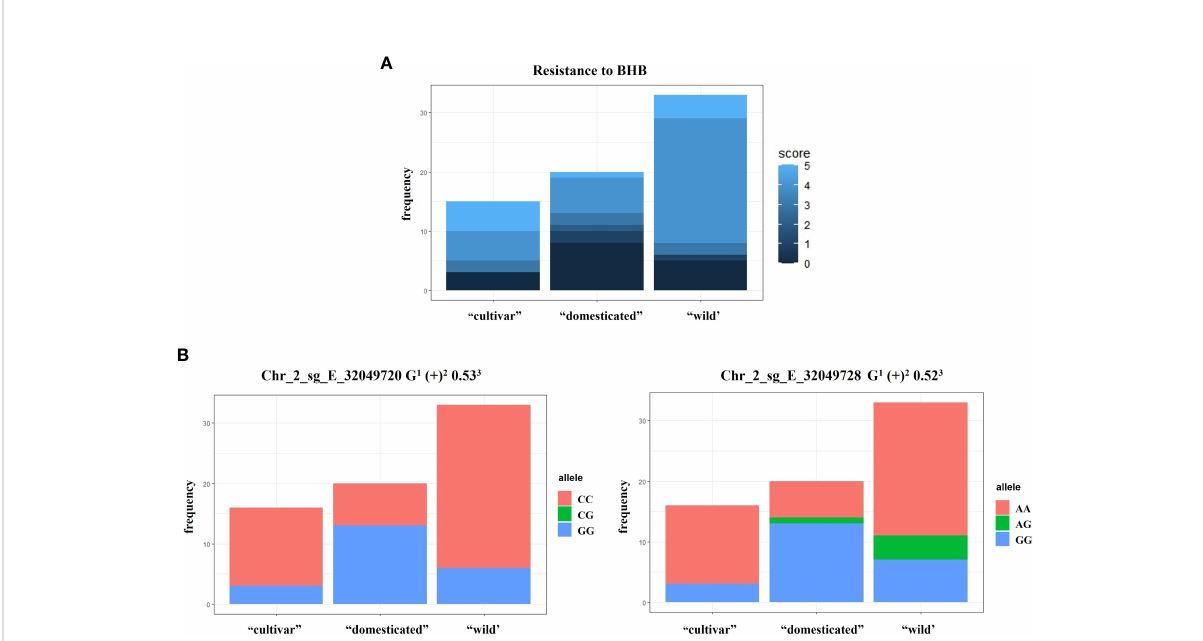
FIGURE 7 Population structure and relation with resistance to BHB. (A) The distribution frequency of accessions resistance to BHB into the “ cultivars ” (n = 16), “ domesticated ” (n = 20), and “ wild ” (n = 33) clusters identi fi ed in population structure Bayesian approach at K = 3. C . arabica Ethiopian accessions classi fi ed as admixed were disregarded in this analysis. The resistance to BHB is based in a scale with a score from 0 to 5, where 0 corresponds to highly resistant plants, 1 to resistant, 2 to moderately resistant, 3 to moderately susceptible, 4 to susceptible, and 5 to highly susceptible. (B) The distribution frequency of the QTNs associated with resistance to BHB into the “ cultivars ” , “ domesticated ” , and “ wild ” clusters. QTN associated with resistance to BHB with its respective location in the C. arabica Et039 genome 1 ; QTN effect 2 ; r 2 (%) of the QTN in relation to the resistance phenotype 3